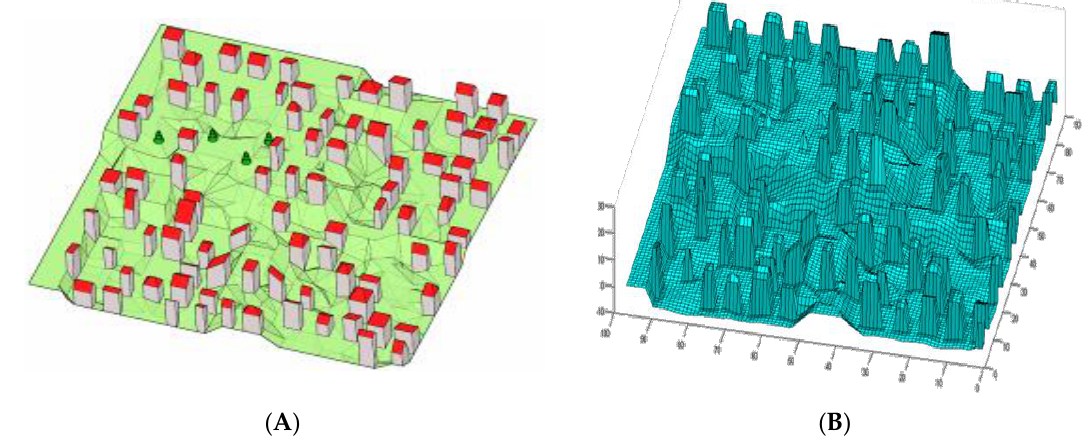
Figure 8. ( A ) CityGML model with level of details two; and ( B ) DSM model with resolution of 200 cm.